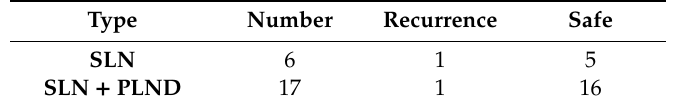
Table 4. Low-volume metastasis DFS considering lymph nodal surgery